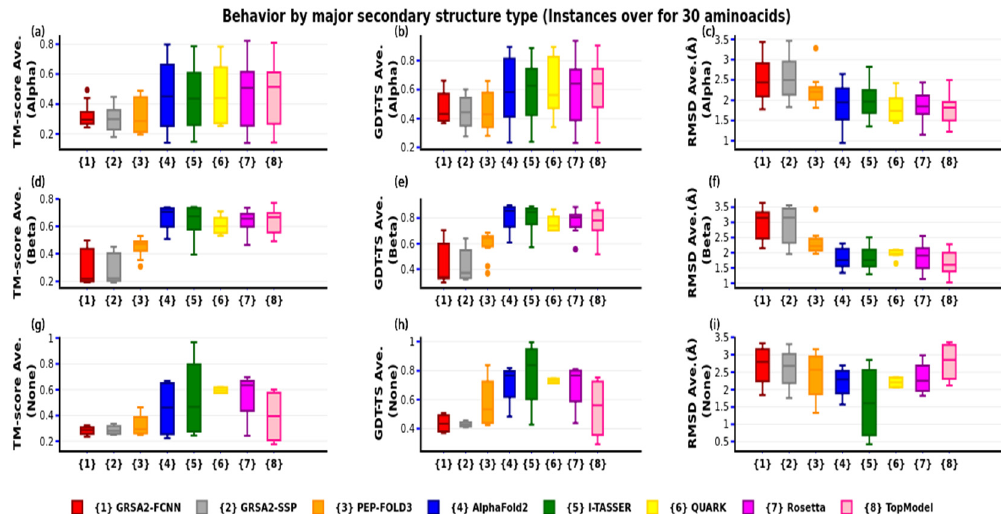
Figure 11. Comparison by major secondary structure type of GRSA2-FCNN versus AlphaFold2, PEP-FOLD3, I-TASSER, GRSA2-SSP, QUARK, Rosetta, and TopModel; TM-score and GDT-TS were used in this comparison. ( a , d , g ) show the set of type Alpha, Beta, and None; they were evaluated with TM-score (average of the five best predictions for each peptide). ( b , e , h ) were made with GDT-TS for Alpha, Beta, and None; and ( c , f , i ) have the RMSD results for Alpha, Beta, and None.